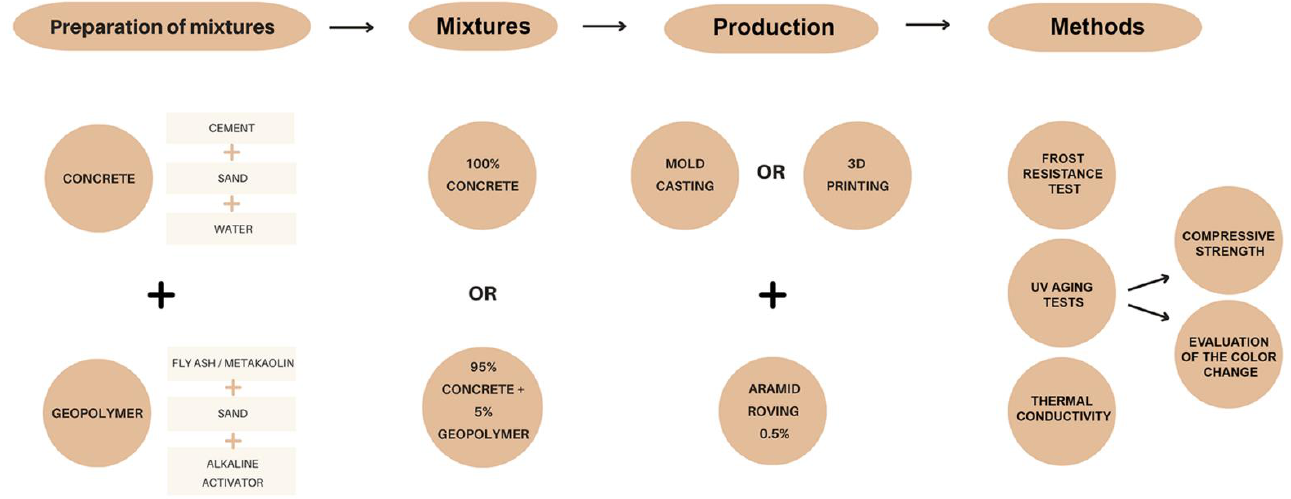
Figure 3. The stages of the production and testing of